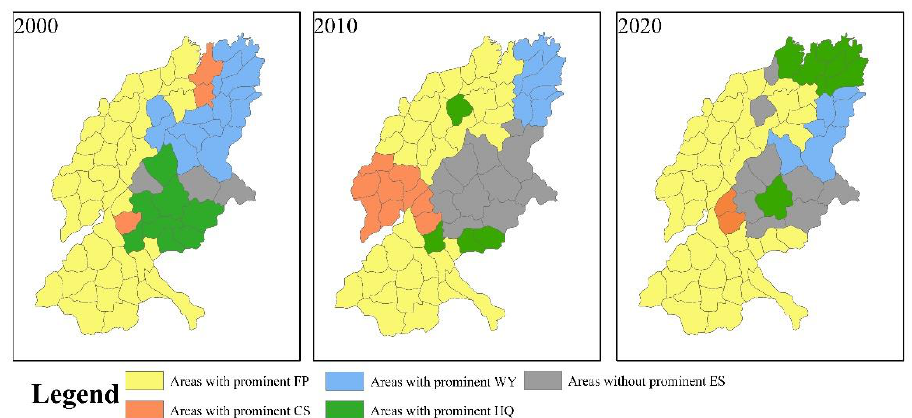
Figure 8. Ecosystem services in which regions are advantaged in trade-offs.